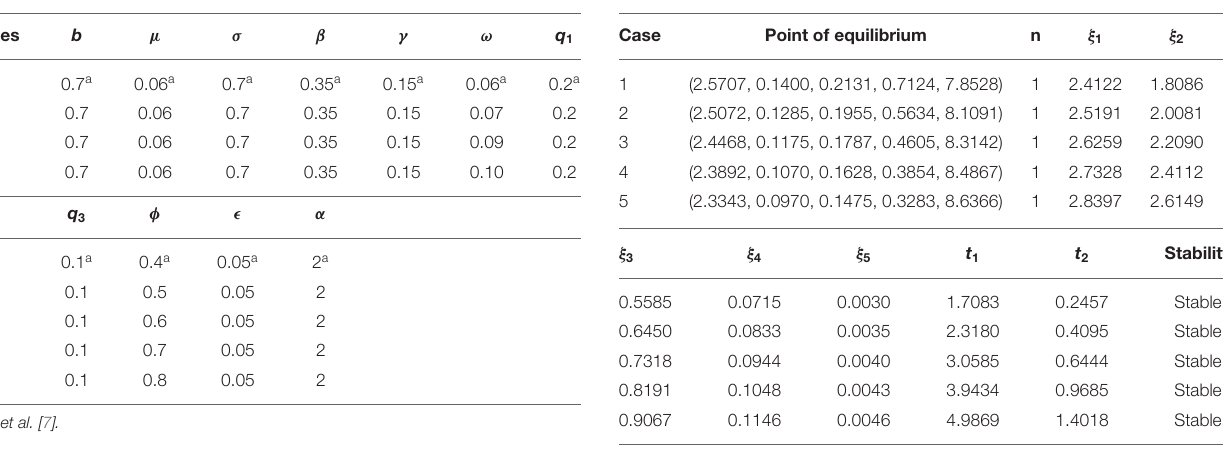
TABLE 1 | Values of parameters. TABLE 2 | Stability of equilibrium